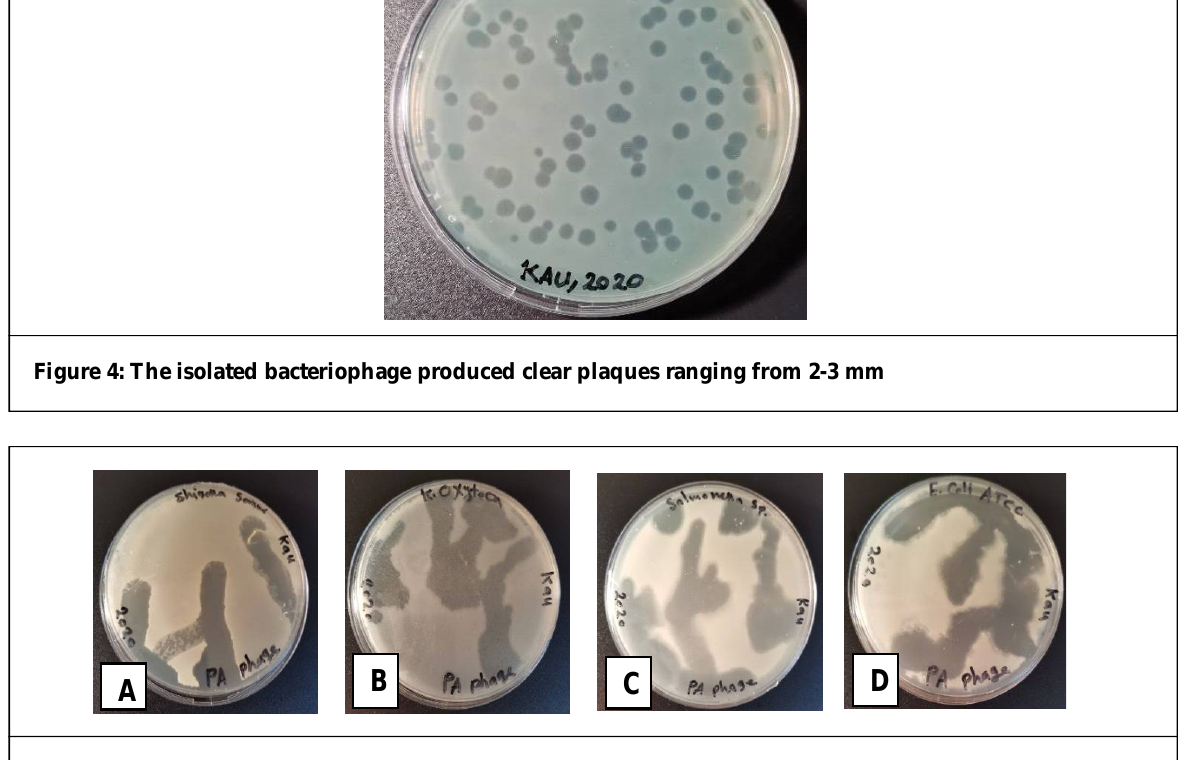
Figure 5: PaMAsh phage host range against six bacterial isolates by using spot assay technique